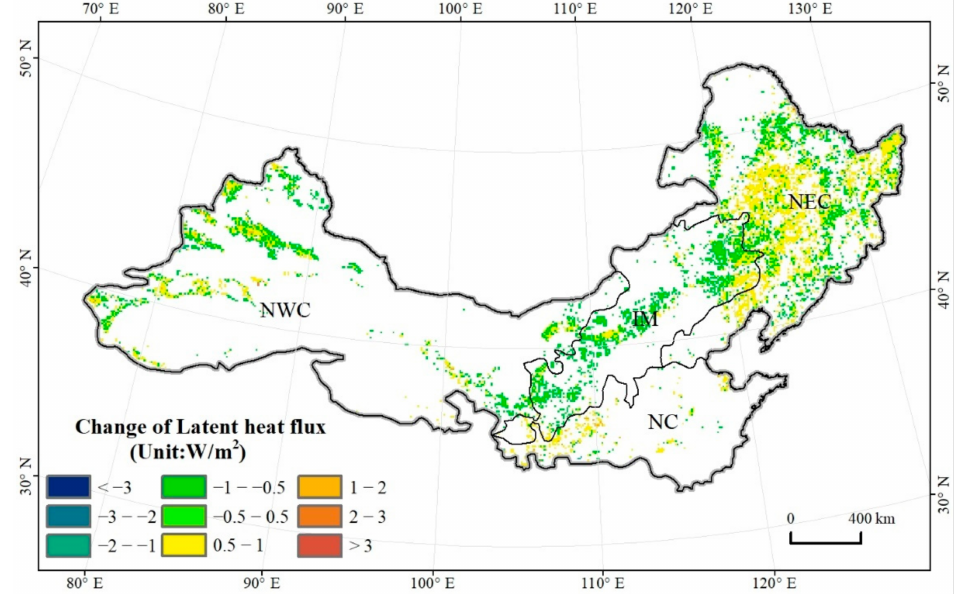
Figure 9. Annuals changes of latent heat flux in the cropland expansion regions during